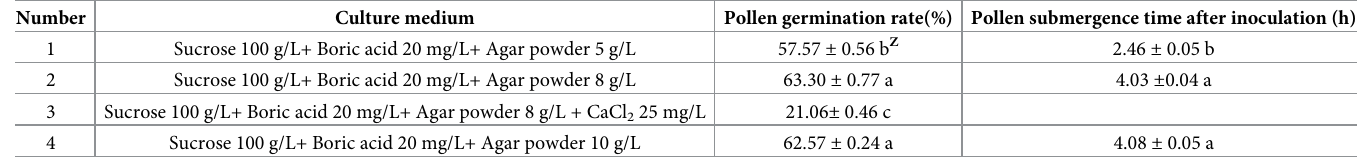
Table 2. Components and pollen germination rates observed three hours after inoculation in different culture media.